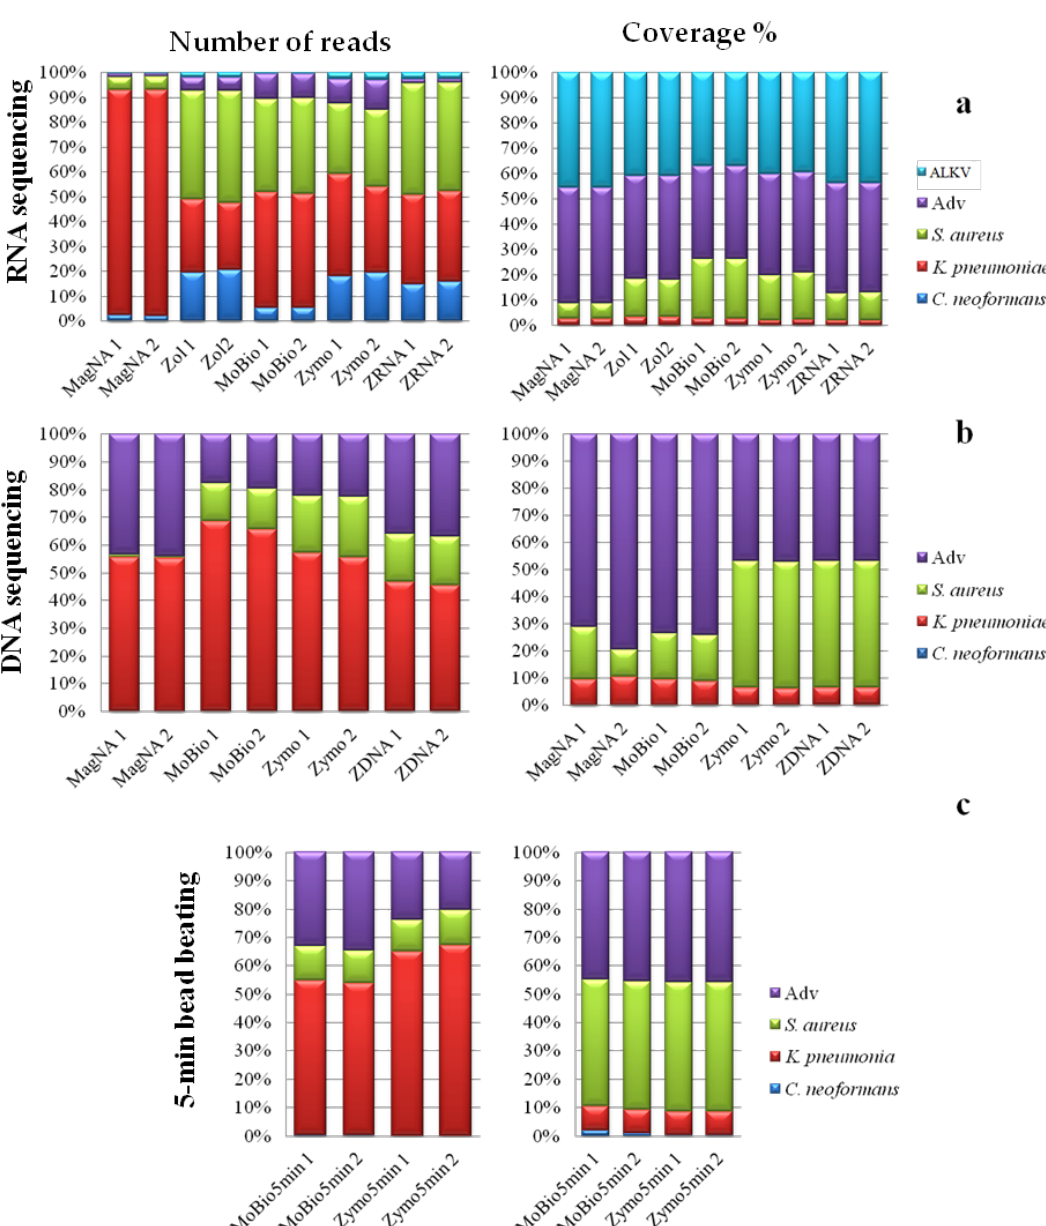
Figure A1. Reads and coverage of microbes in the mock sample. The diagrams on the left represent the number of reads assembled for the spiked pathogens, and those on the right show the percentage of the microbe reference covered by the reads for the duplicates of each extraction method. ( a ) Generated data from RNA sequencing; ( b ) generated data from DNA sequencing; and ( c ) generated data from 5-min bead beating agitation.